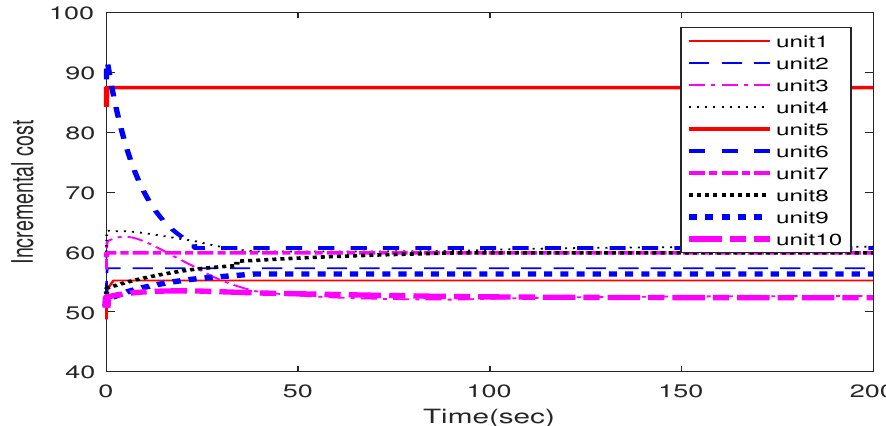
Figure 8. Incremental cost consensus in case of generation capacity limit constraint.